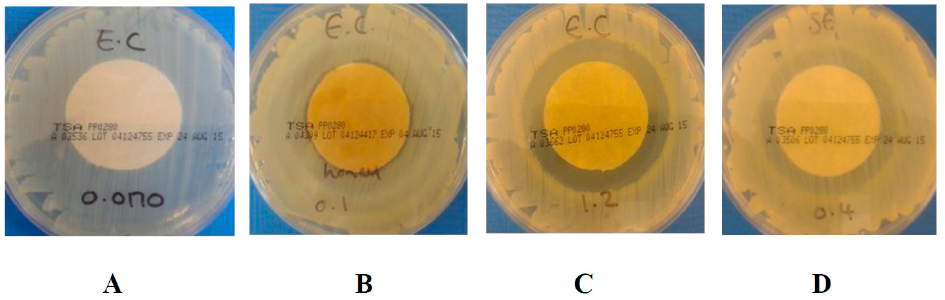
Figure 3. Examples of zones of inhibition formed around both MH and MGO coated nonwoven samples. A = no zone ( E. coli ); B = 0–1 mm ( E. coli ); C = >1 mm ( E. coli ) and D = unclear zone ( S. aureus ). Note: all coated samples were 3 cm in diameter.